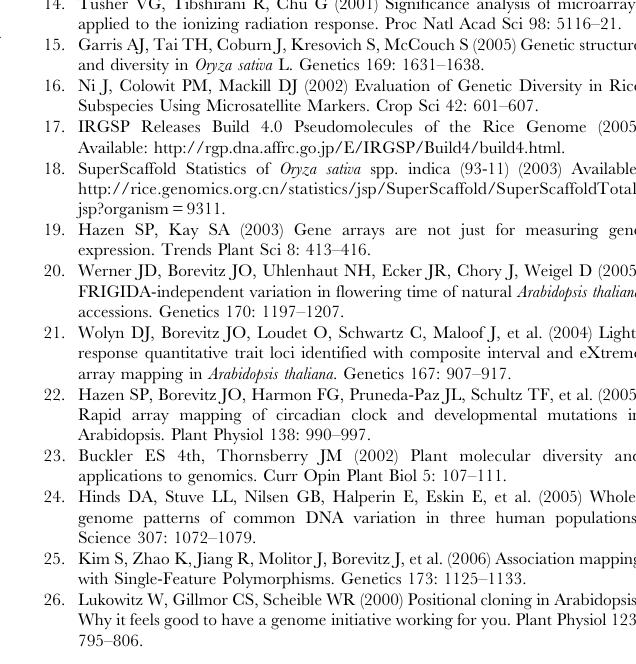
Table S2 Sequence verified SFPs in CP&RT dataset. Changes in sequences are highlighted in blue and black; - indicates deletion; CP = Cypress and RT =RT0034.